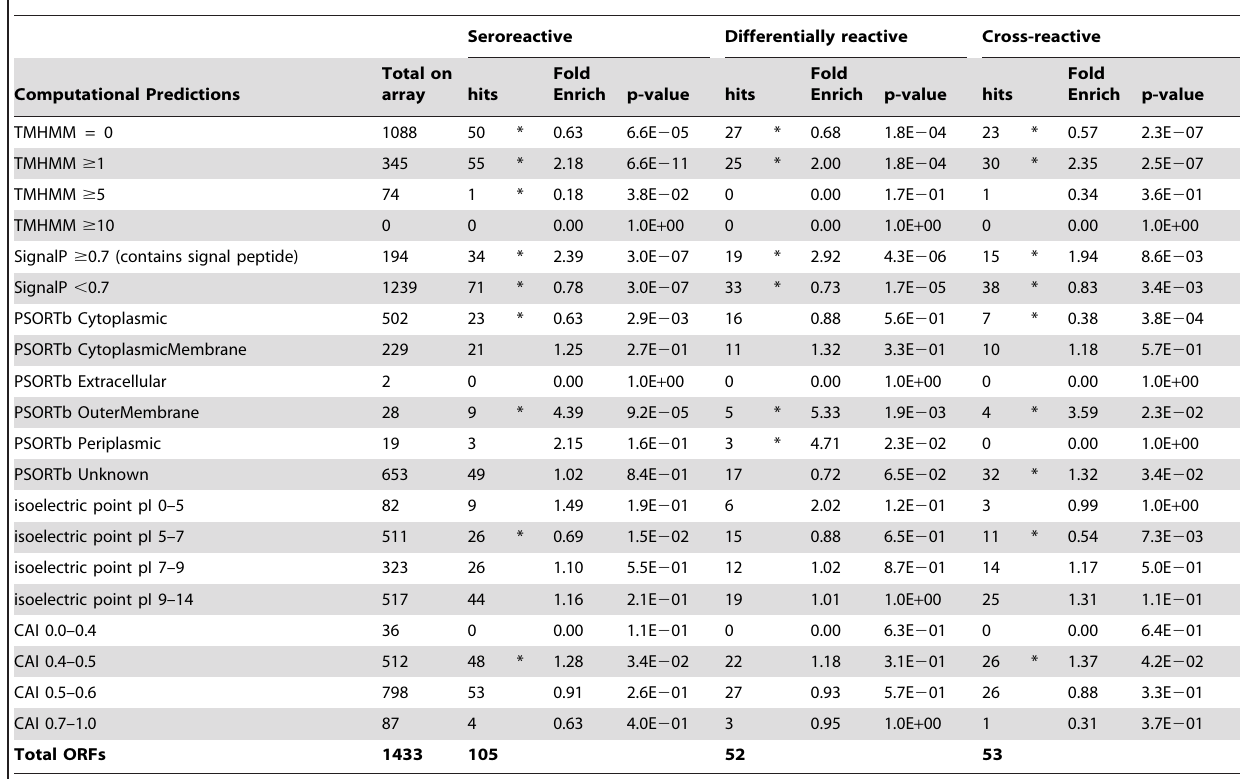
Enrichment table of computationally predicted functional groups for seroreactive, serodiagnostic, and cross-reactive antigens. The numbers of proteins printed on the array for each predicted feature are totaled under ‘‘Total on array.’’ Seroreactive, serodiagnostic, and cross-reactive proteins with predicted features are totaled as ‘‘counts’’. Asterisks denote significant values.